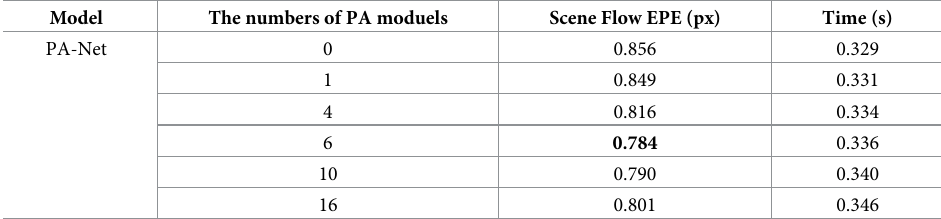
Table 4. Results of EPE by adding different number of PA modules on Scene flow dataset.